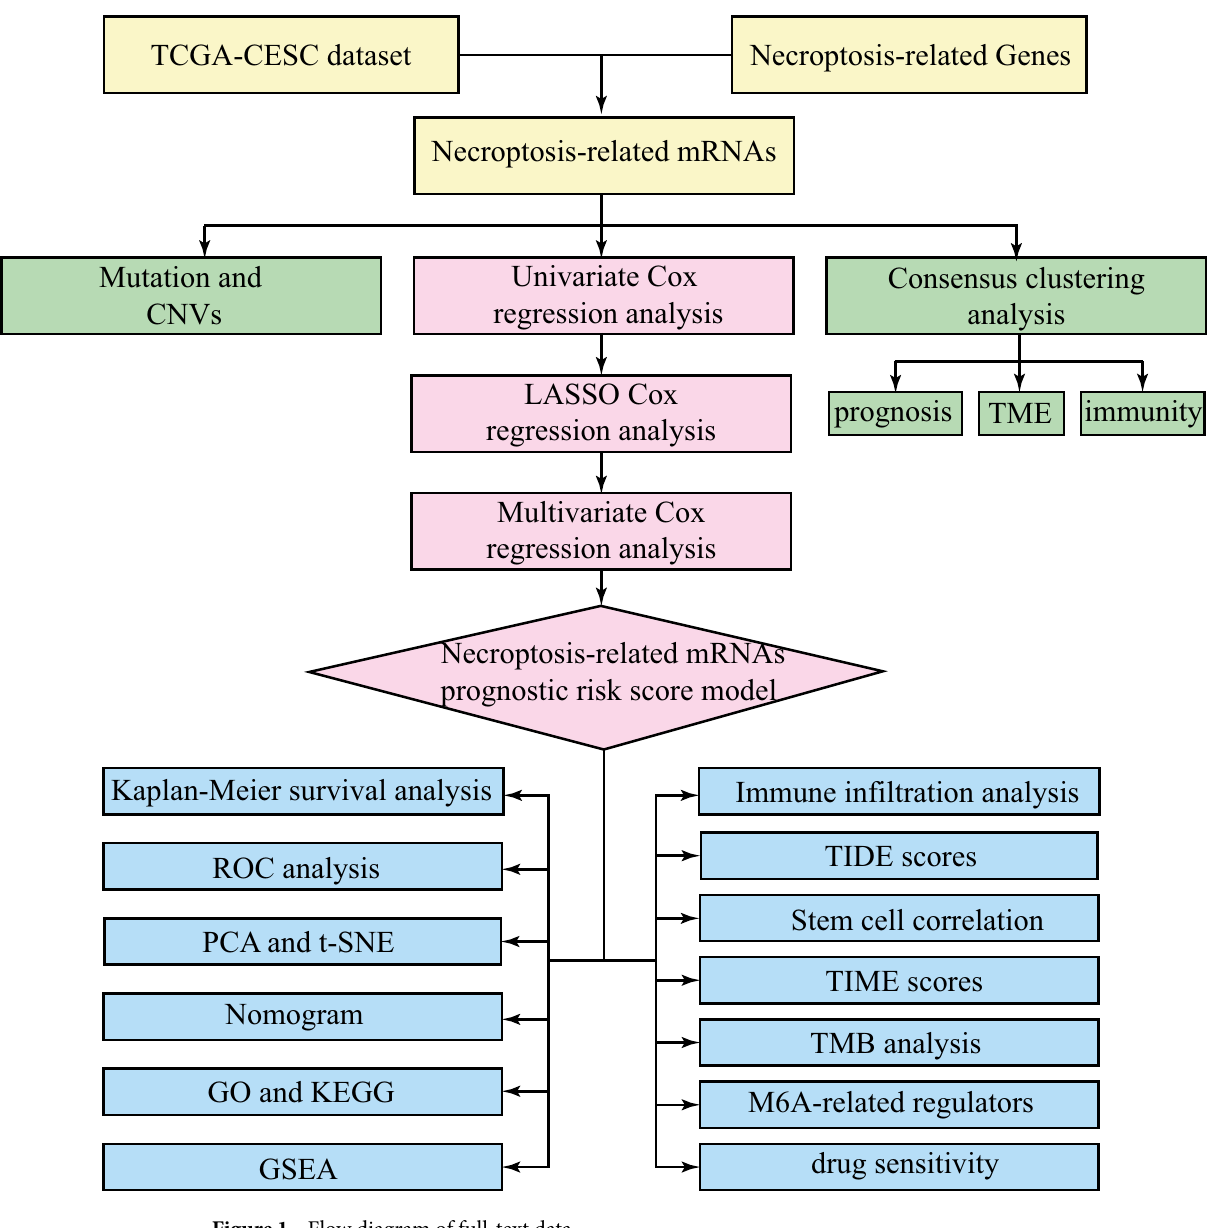
Figure 1. Flow diagram of full-text